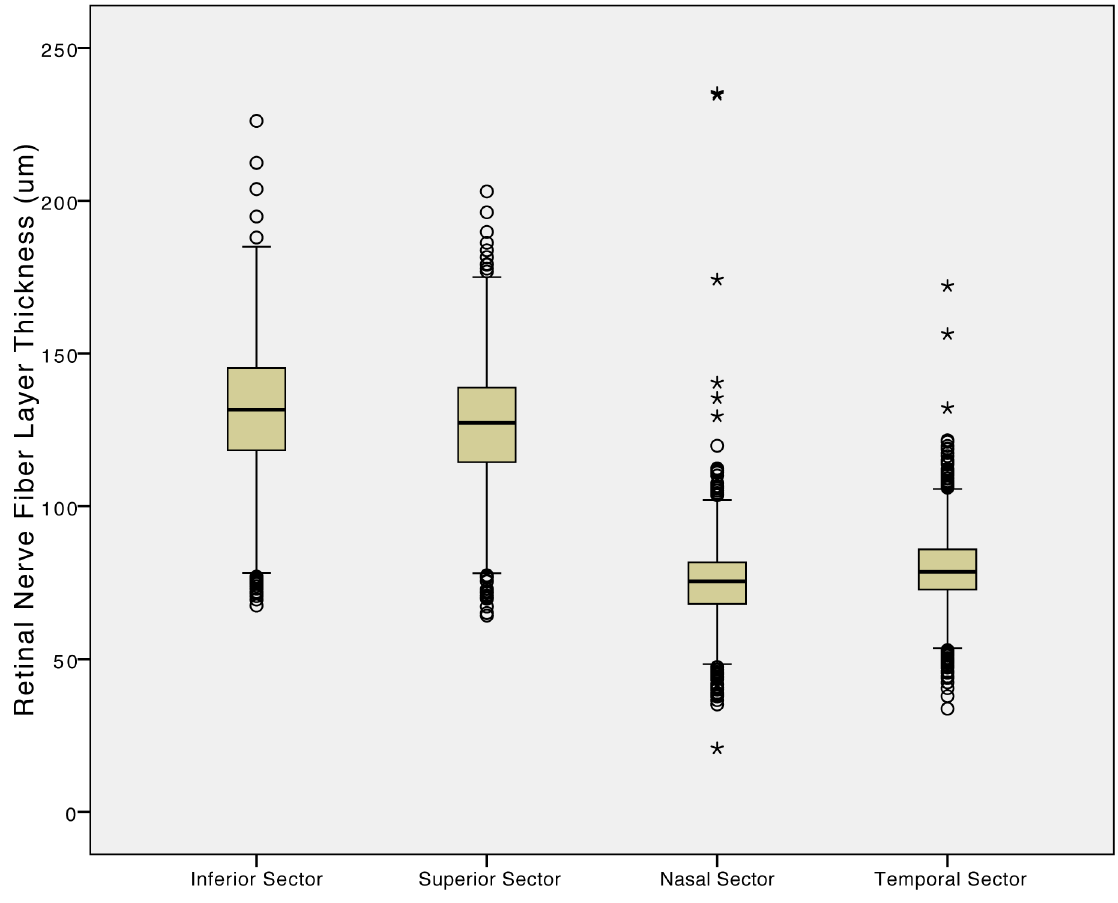
Figure 1. Boxplots showing the distribution of retinal nerve fiber layer thickness measured by spectral domain optical coherence tomography (iVue SD-OCT) in four parapapillary sectors in the Beijing Eye Study